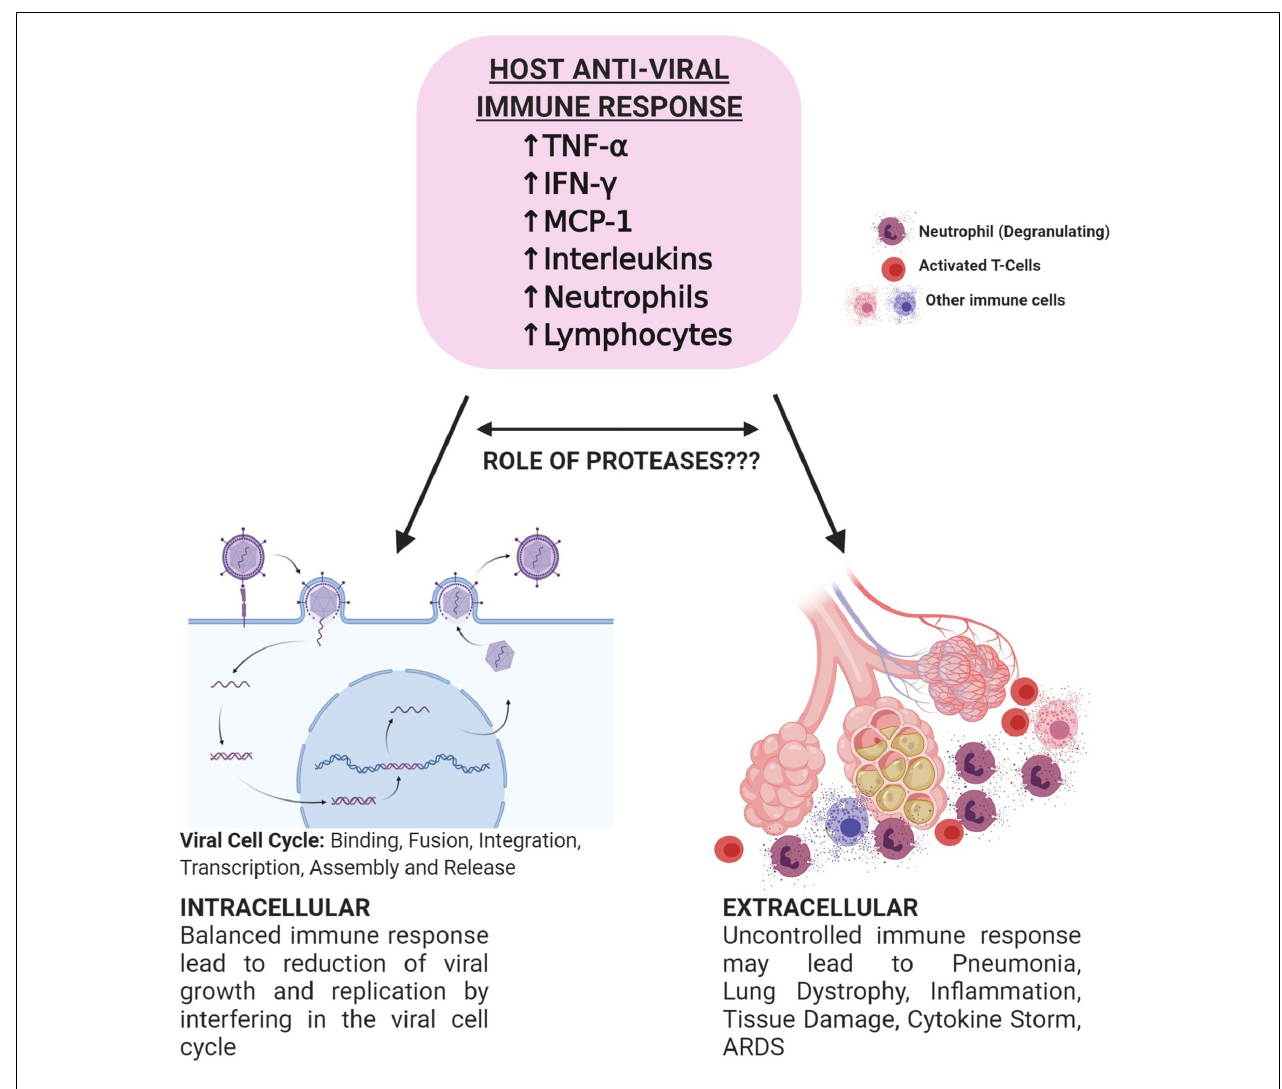
FIGURE 2 | Schematic representation of potential bi-directional innate immune response against viral infections. Successful initiation of IFN- α / β related response leads to the suppression of viral infection at the early stage. SARS-CoV-2 hinders type 1 IFN related response and leads to the active replication of the virus. Increased viral load later causes hyperactivation of the immune system and may lead to lymphopenia, neutrophilia, and thrombocytopenia. Immune cells secrete proteases that play roles in the alteration of immune response. Targeting proteases may aid in controlled immunity and decrease the severity of the disease. Figure prepared on biorender.com, professional science figure creating